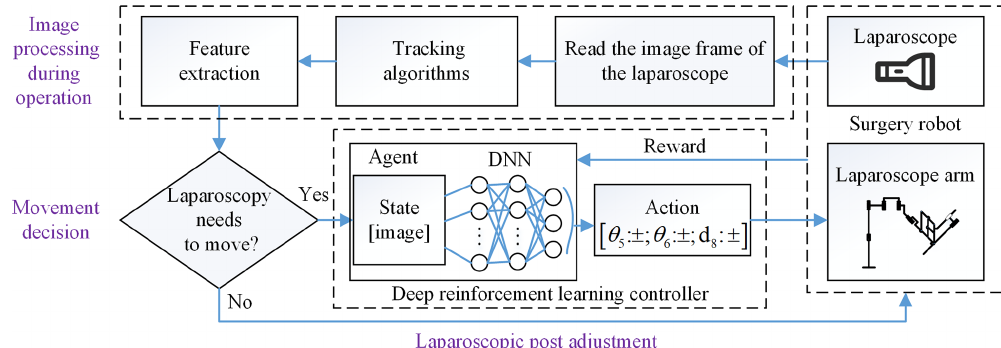
Figure 2. Laparoscopic pose automatic adjustment method.